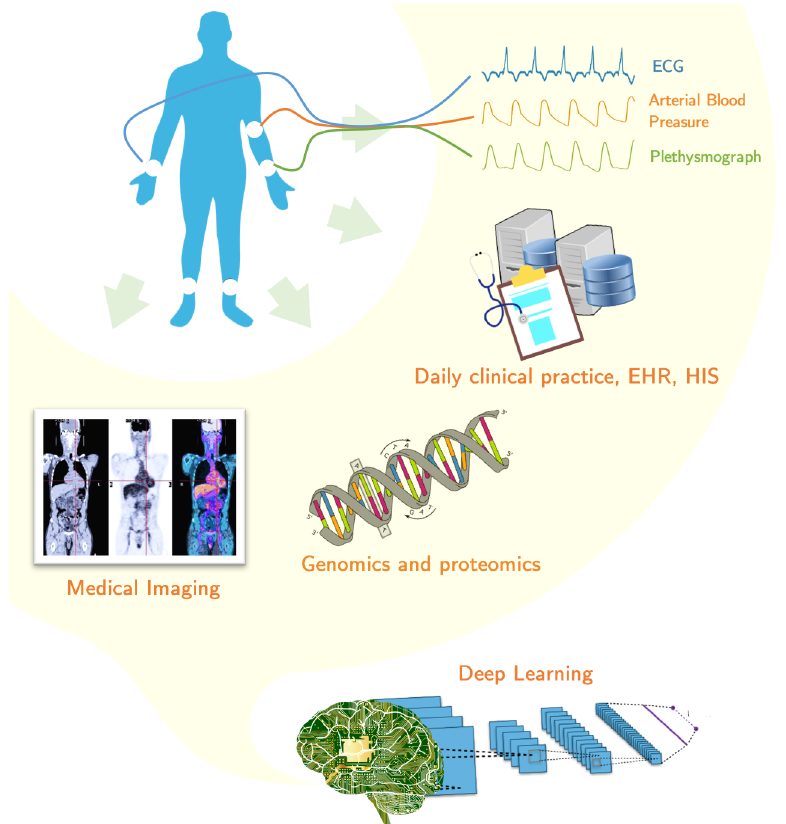
Figure 1. Illustration of how biomedical information (biomedical signals and images, genomic sequences, or EHRs) can be managed by BD and DL with the aim of assist physicians in particular domains of